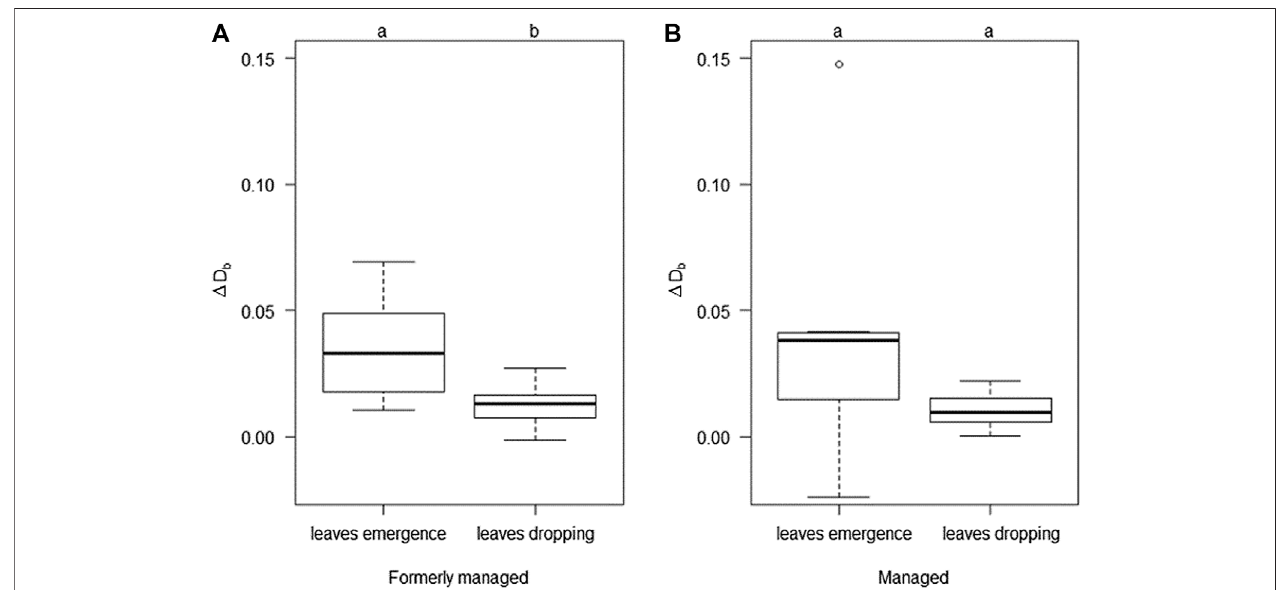
FIGURE 6 | Box-Whisker plot of the difference in box-dimension ( Δ D b ) resulting from the foliation during spring (leaves emergence) and the defoliation during fall (leavesdropping)overthetwodifferentmanagementtypes.Blackhorizontallinesindicatethemedian(Formerlymanaged (A) :n=6for “ leavesemergence ” andn=7for “ leavesdropping ” ;Managed (B) :n=7for “ leavesemergence ” andn=7for “ leavesdropping ” ).Lowercaselettersindicatesigni fi cantdifferencesamongtheconditionsat the level of p <